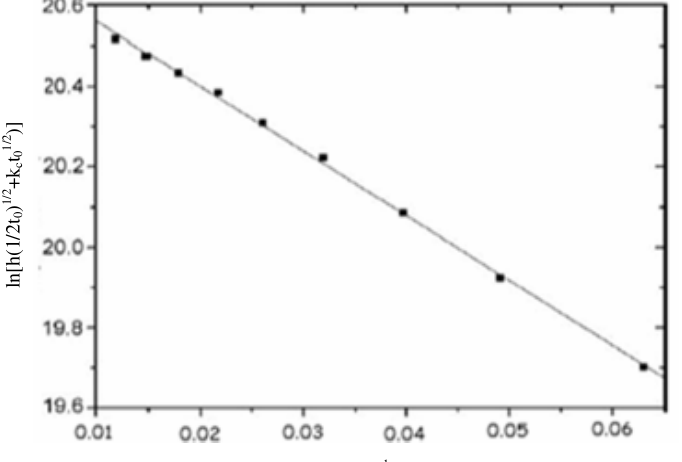
Figure 6 . Data from evaporation of liquid vapour ( n -hexane) into carrier gas at 313.15 K and 1atm ( v =1.0 cm 3 s -1 ), plotted according to Eq. 21 Table 1 summarizes the results obtained with all liquid studied. In the same table the diffusion coefficients determined here were compared with those calculated